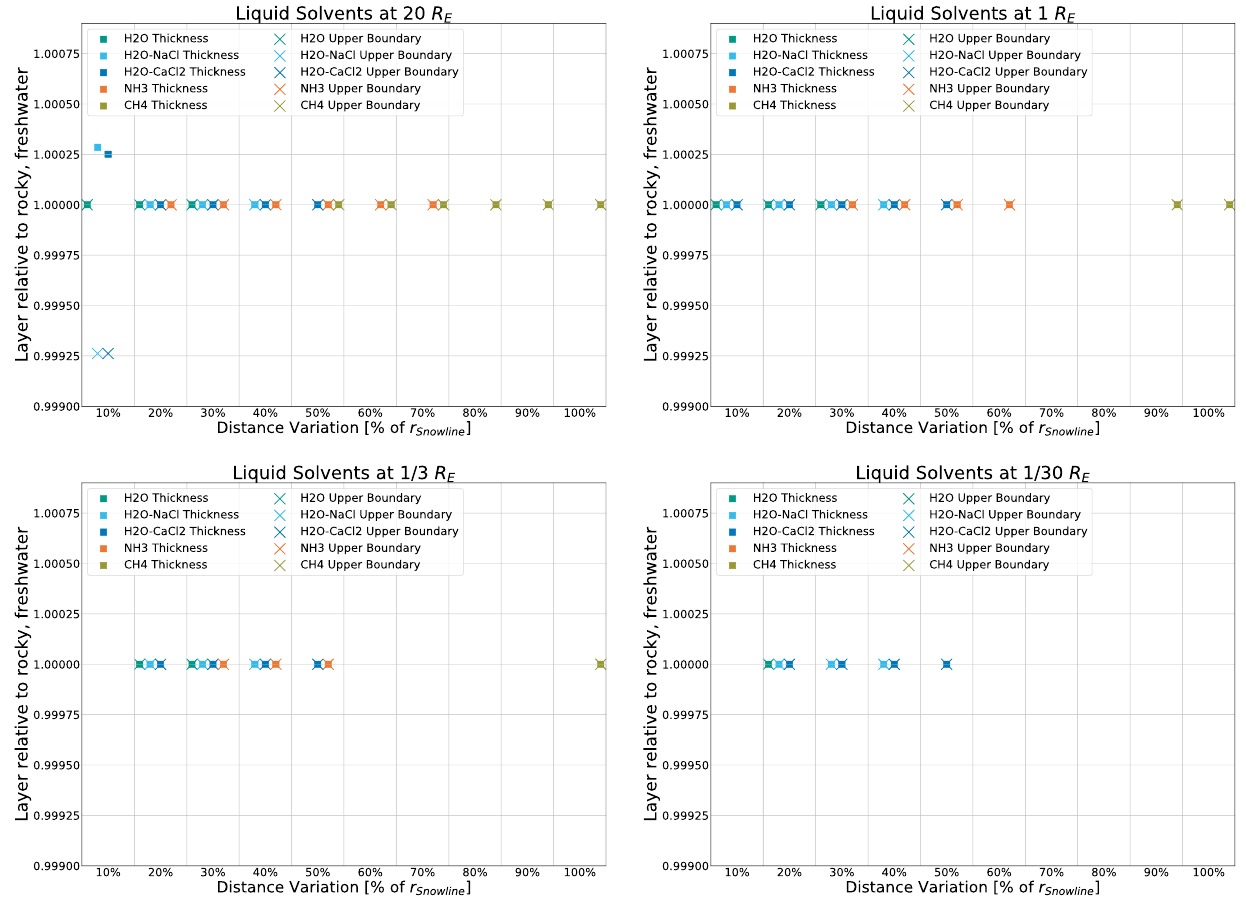
Figure A3. Deviation from the rocky, freshwater model for liquid layer thickness and upper boundary for a rocky crust with NaCl -saltwater inclusions.